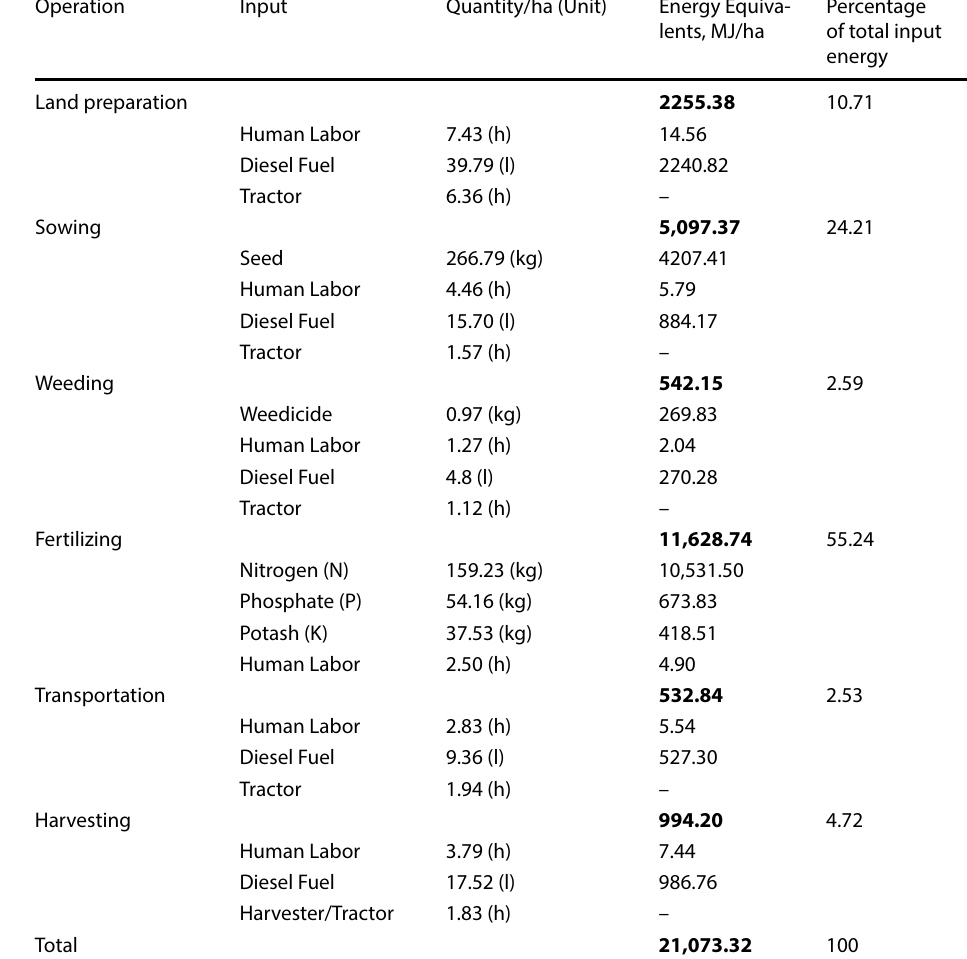
Table 11 Distribution of energy by field